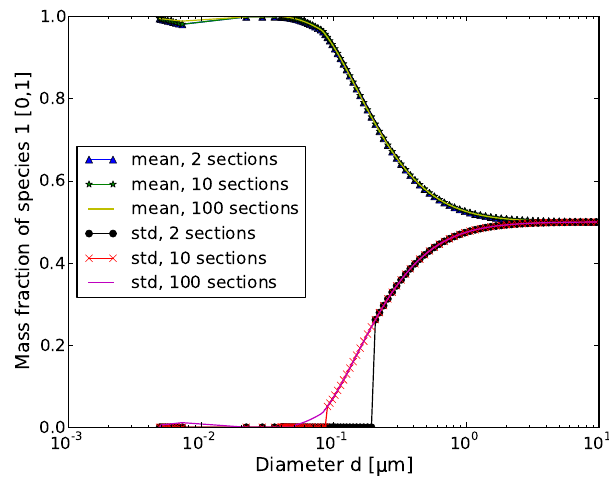
Figure 2. Mean and standard deviations of species 1 mass fraction as functions of particle diameter using 2, 10 and 100 composition